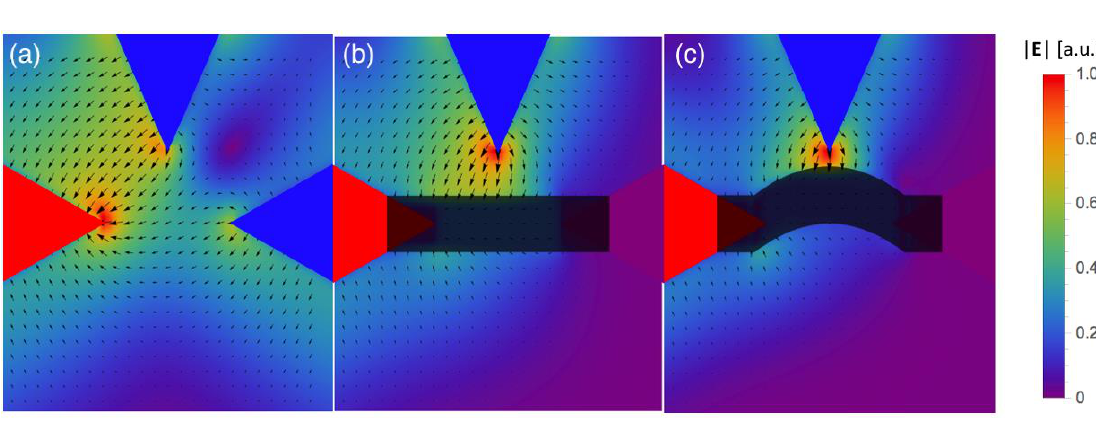
Figure 7. Electric fields in the switch: ( a ) at the initial state, ( b ) when preliminary arc strikes, and ( c ) after arc deflection. Electrode potential is color-coded with red > purple > blue.